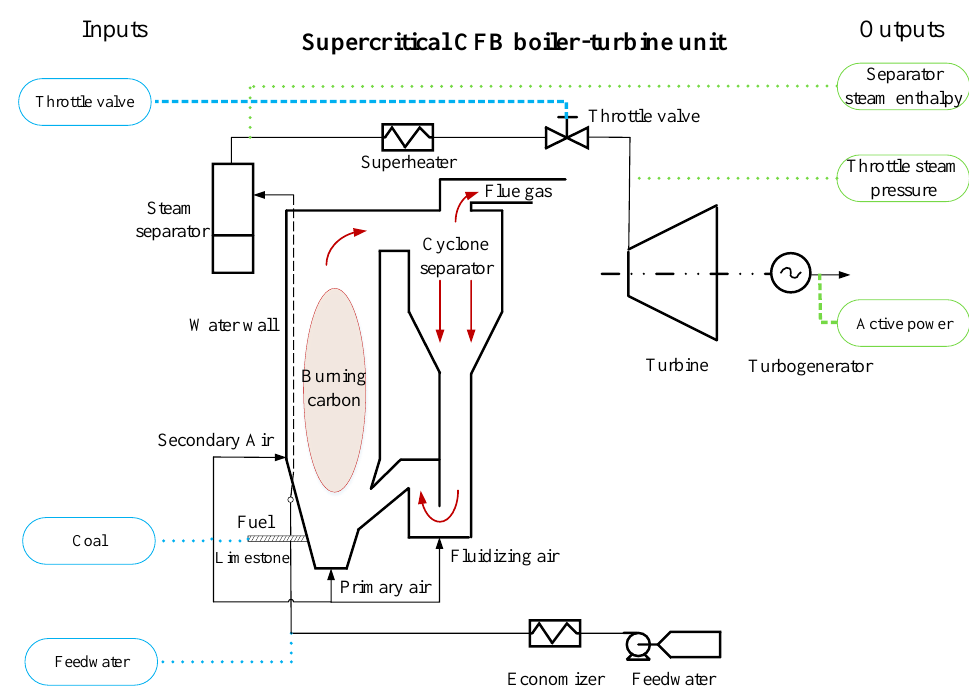
Figure 1. Simplified diagram of a supercritical circulating fluidized bed (CFB) boiler-turbine unit.